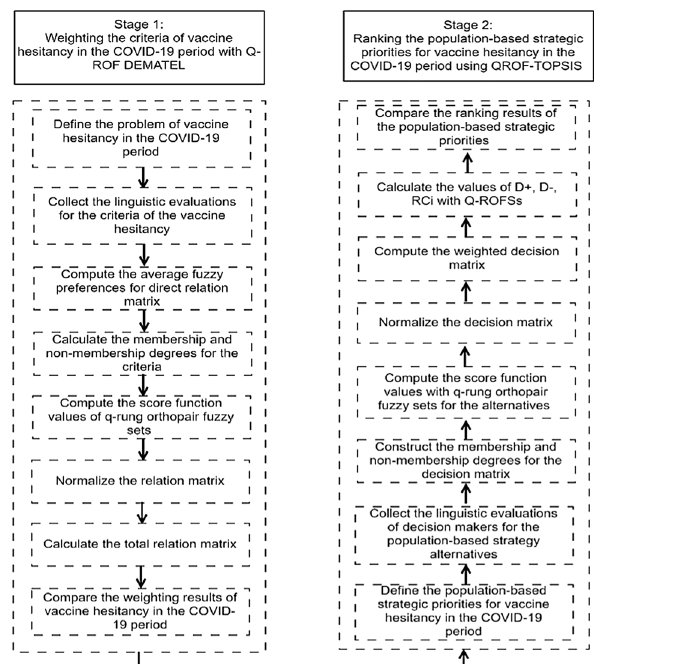
Fig. 2 The flowchart